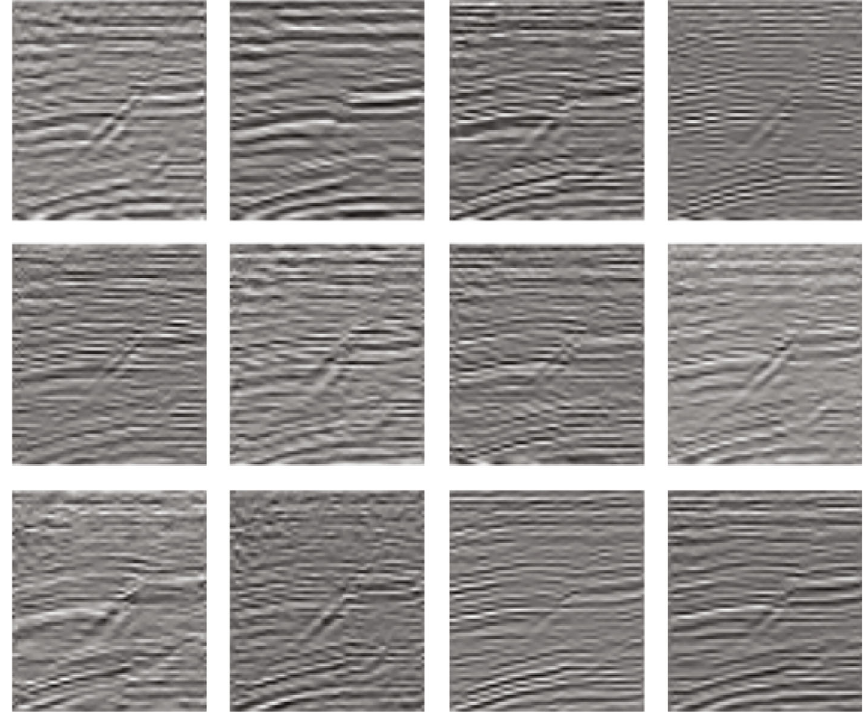
Figure 8: ResNet-50 feature map.